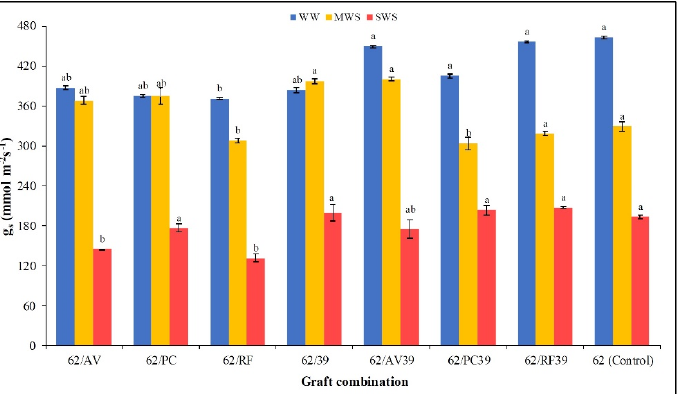
Figure 4. Stomatal conductance (g s ) in graft combinations in different levels of water stress. Values followed by the same letter are not significantly different at p ≤ 0.05 according to DMRT.